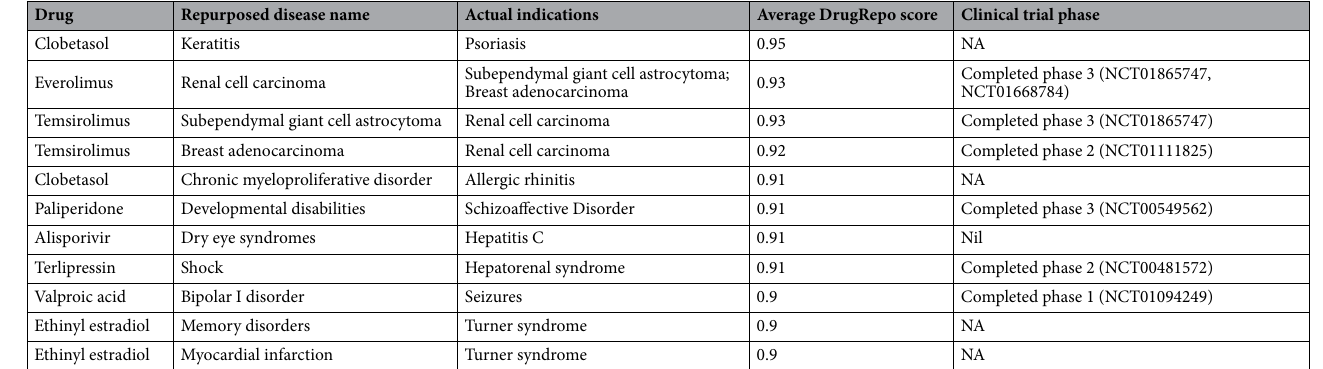
Table 1. Drugs repurposed by DrugRepo at average score ≥ 0.9.